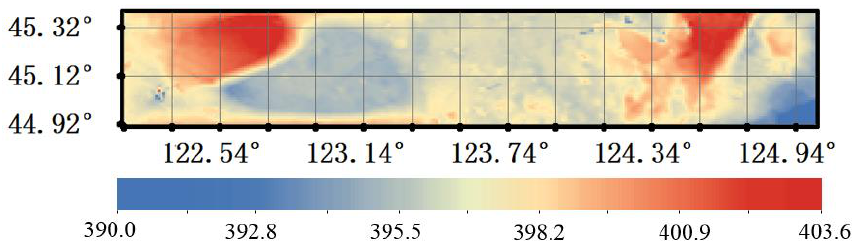
Figure 9. The XCO 2 concentrations in the flight test area estimated with HASM.